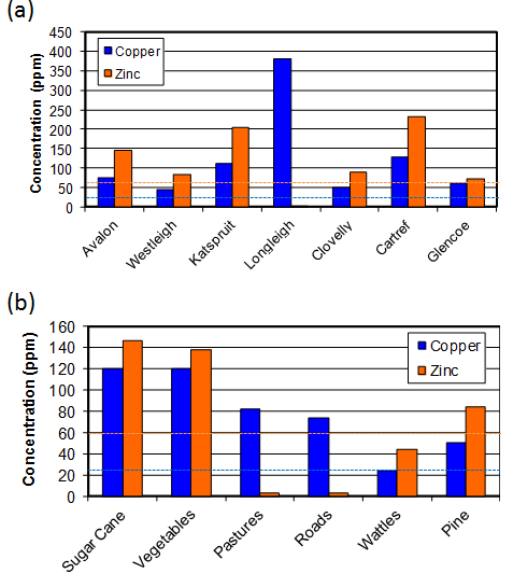
Fig. 10. Mean concentrations of Cu and Zn calculated for (a) up- land soil and (b) land use. Dashed lines represent global average Cu (blue) and Zn (orange) concentrations within soil reported by Buonicore